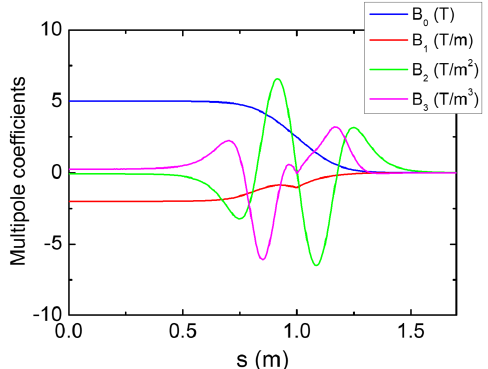
FIG. 6. Magnetic field distribution along the midplane of the superconducting 90° combined-function magnet. The origin of the x coordinates is the center of the magnet bore.